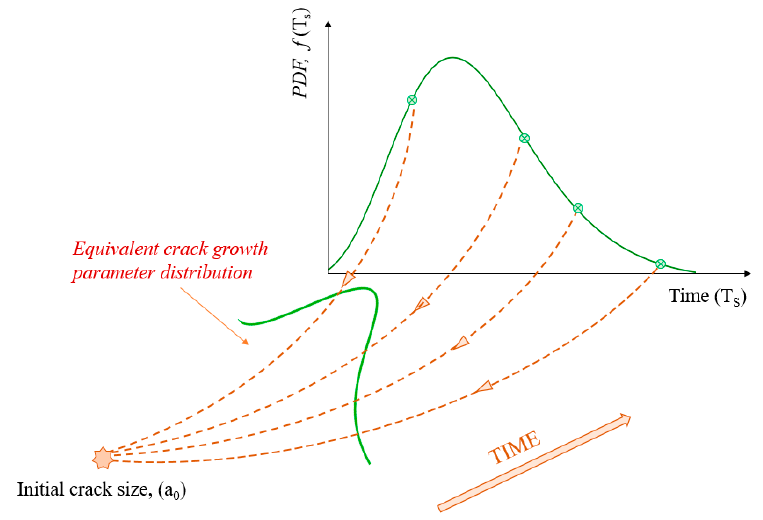
Figure 7. Obtaining the equivalent crack growth parameter distribution.